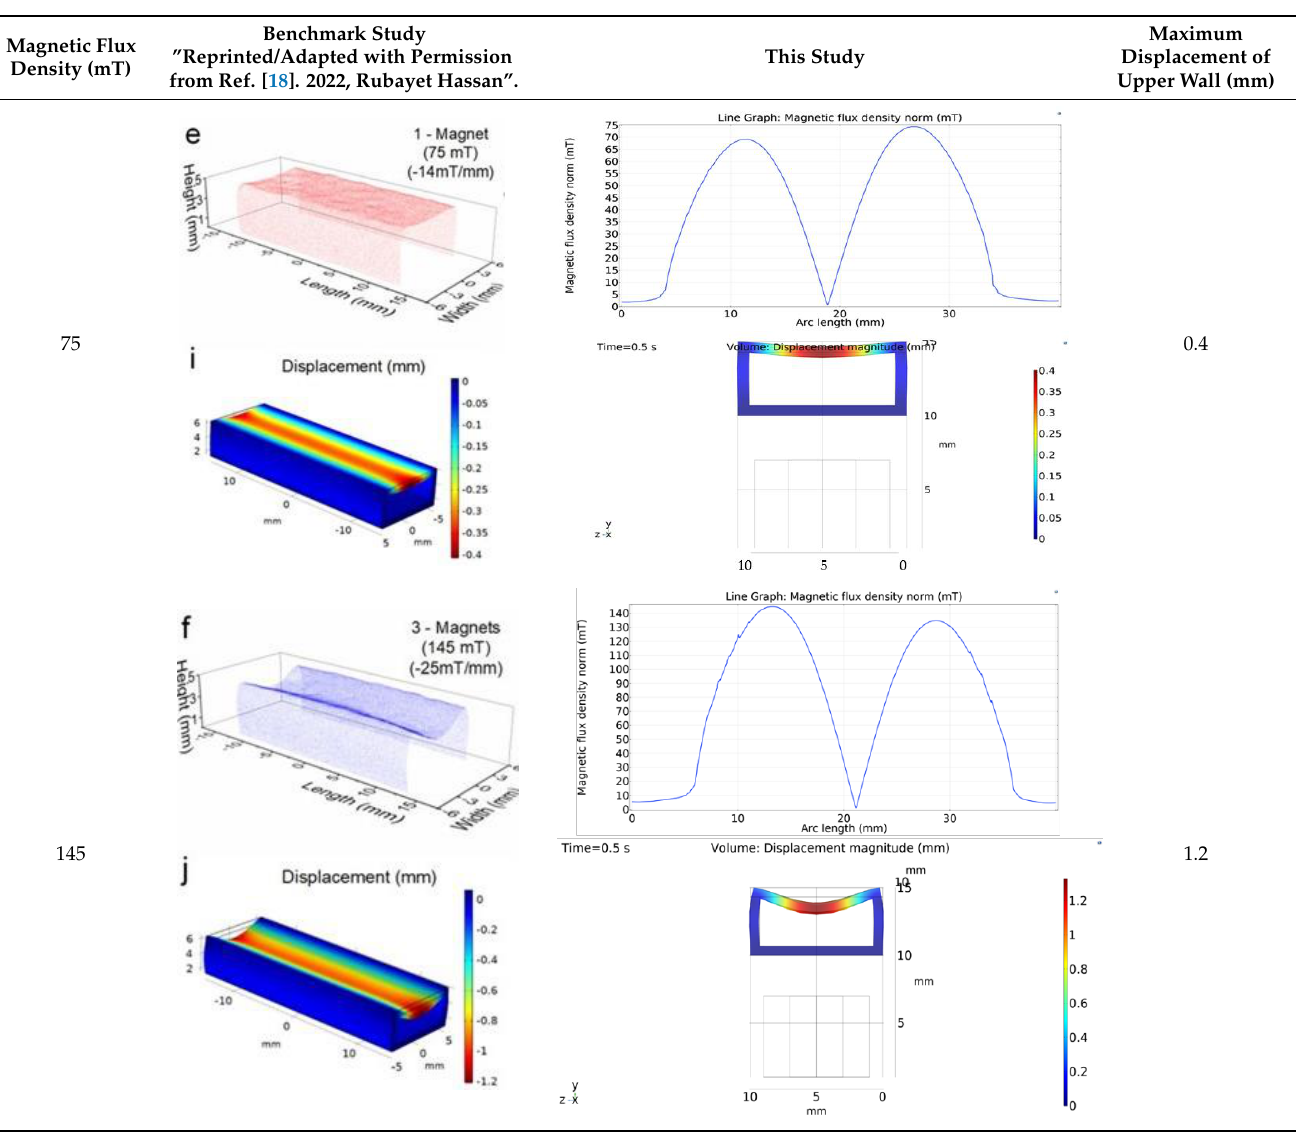
Table 4. Comparisons of simulations between this study and benchmark study: (e)–(g) 3D shape of pipe under 75 mT, 145 mT, and 175 Mt during experimental study; (i)–(k) The deformation simulation corresponding to the experimental study in (e)–(g) “Reprinted/adapted with permission from Ref. [18]. 2022, Rubayet Hassan”.